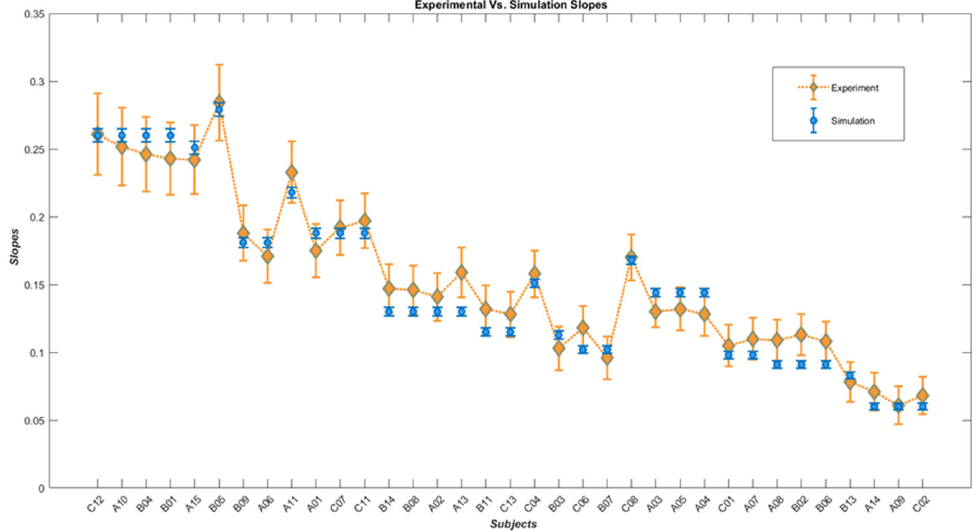
Figure 7. Diamonds represent the slopes of the subjects’ psychometric functions while black dots demonstrate the simulated slopes.